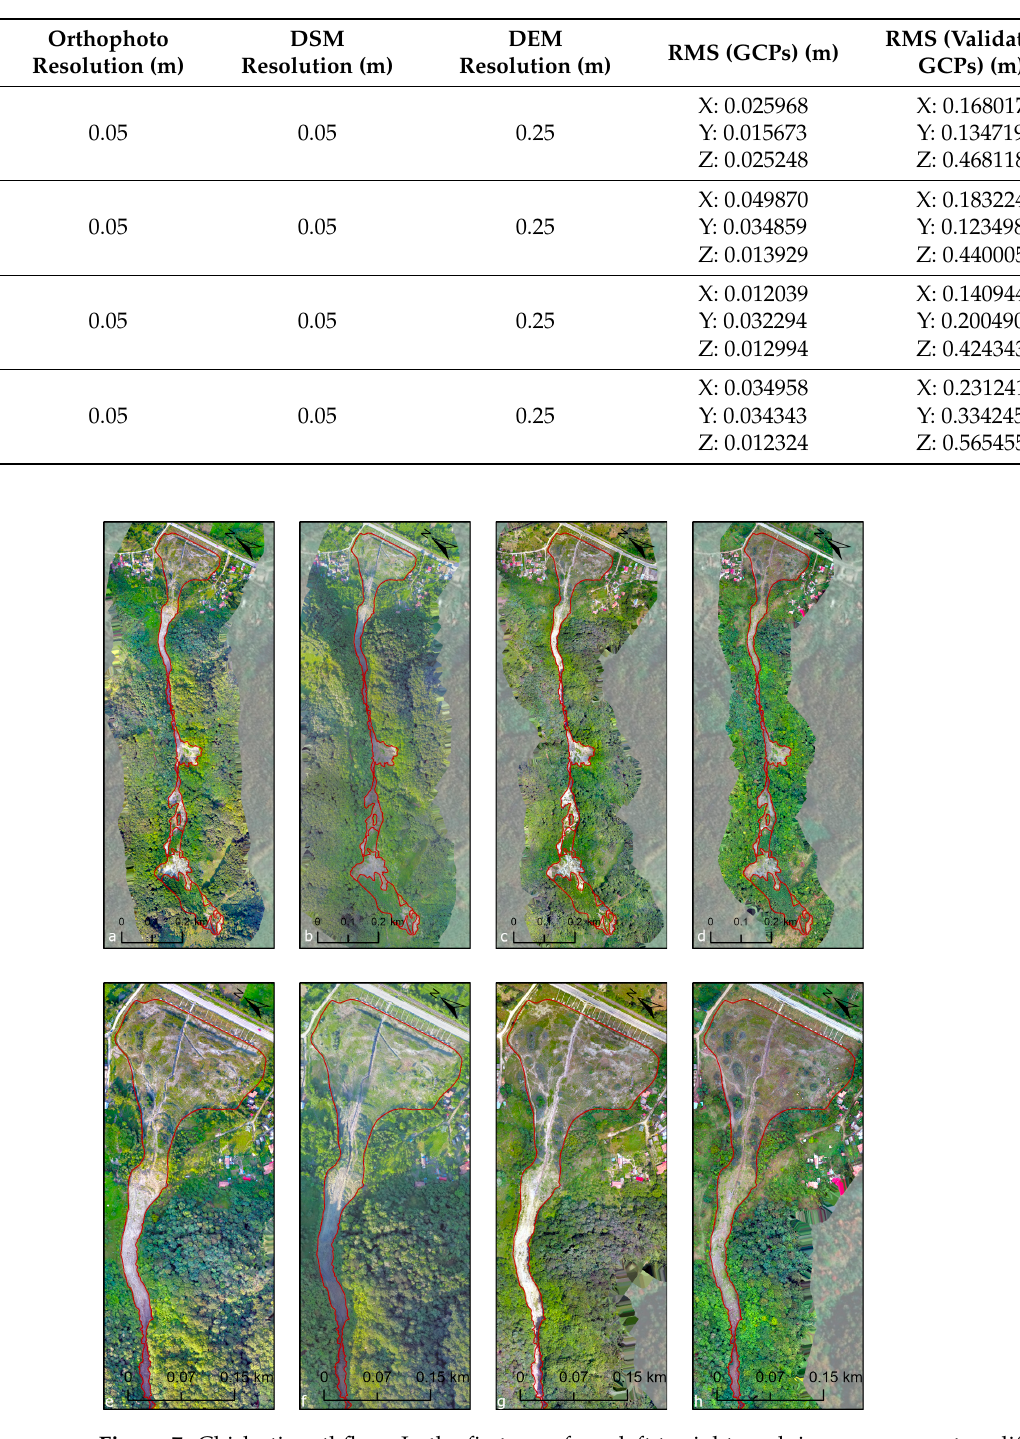
Table 2. Overall accuracies of the SfM process. RMS for target and validation GCPs are presented in meters.